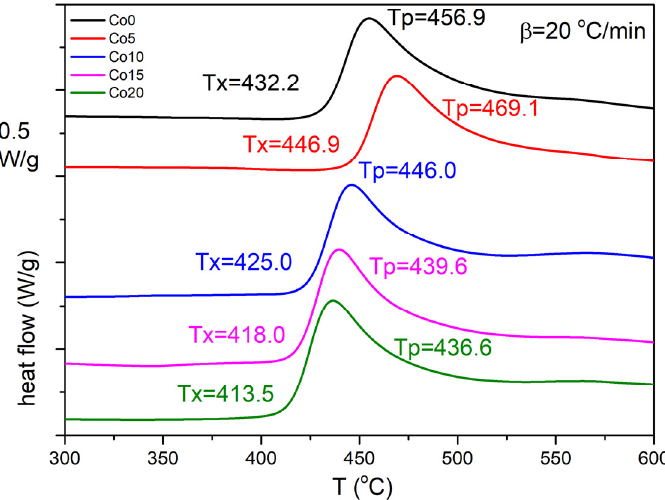
Figure 2. Differential scanning calorimetry curves of Fe 84.5-x Co x Nb 5 B 8.5 P 2 (x = 0–20 at.%) alloys. The heating rate is 20 °C/min.